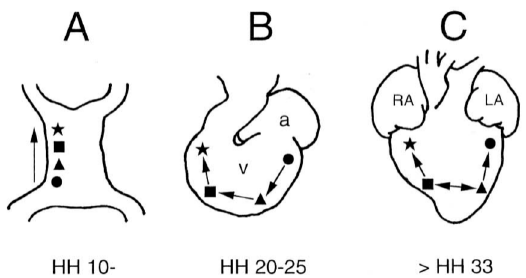
Figure 1. Activation sequence transitions. Activation sequence of the developing heart from tubular stages ( A ), looping stages ( B ), and after completion of septation to become 4-chambered ( C ). The activation sites represent the LV base (circle, ● ), LV apex (triangle, ▲ ), RV apex (square, ■ ) and RV base (star, ★ ). a=atrium, v=ventricle, RA = right atrium and LA=left atrium. From [14].